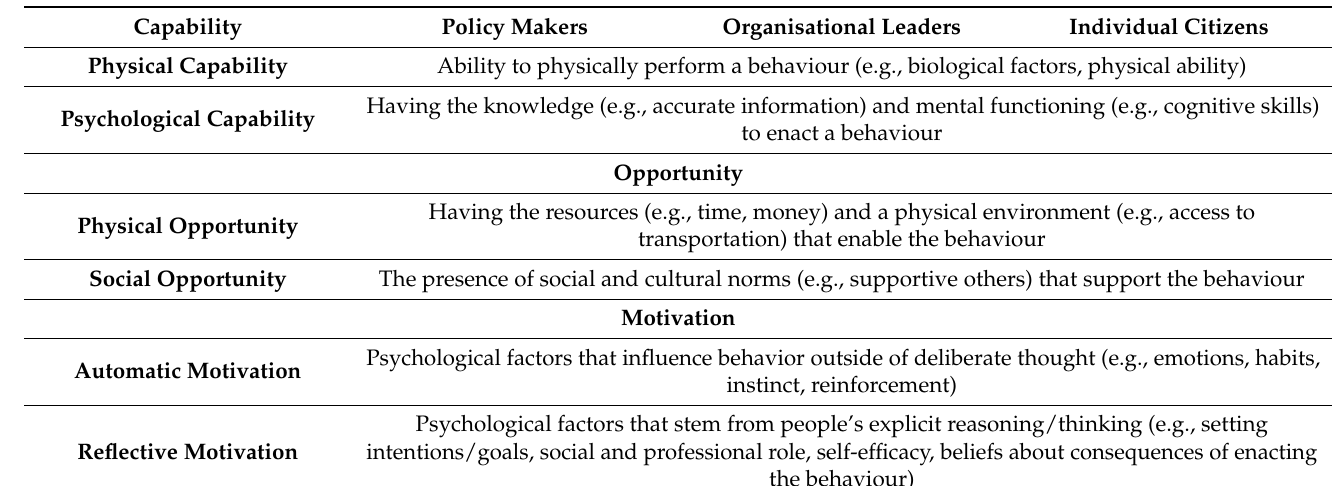
Table 2. The Capability, Opportunity and Motivation (COM-B)